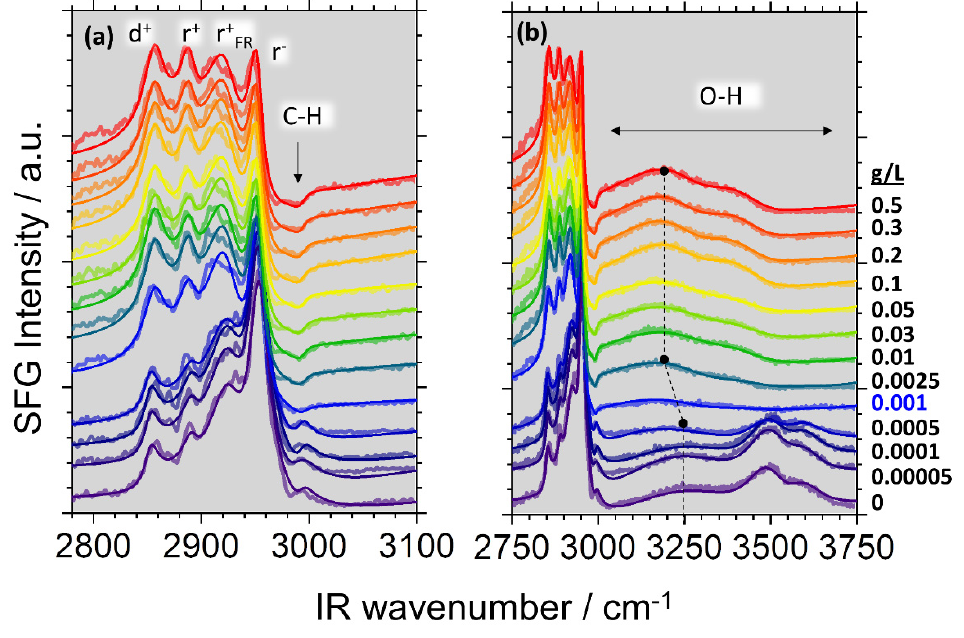
Figure 1. Vibrational SFG spectra of air–water interfaces modified by saponin–chitosan mixtures as a function of the chitosan concentration, which was as indicated on the right axes of the panel ( b ). Note that the saponin concentration in the aqueous solution was fixed at 0.1 g/L, while the chitosan concentration was varied. The solution contained 0.1 wt% acetic acid in order to adjust the pH value to 3.4 for all chitosan concentrations. Spectra were offset for better visual inspection. Panel ( a ) shows a magnified view of the SFG spectra that concentrate on the details of C-H modes from interfacial molecules. Bands assignments to CH 2 (d + ) and CH 3 (r + ), the Fermi resonance r +FR , the CH 3 asymmetric stretch (r − ) and a C-H stretch (C-H) are labelled in ( a ) and also discussed in the main text. Panel ( b ) overviews spectra that show both C-H and O-H modes from interfacial molecules, such as the broad O-H stretching modes which are indicated. The dotted line highlights the red shift of the OH frequency as the concentration of chitosan increases. (See details in the main text).